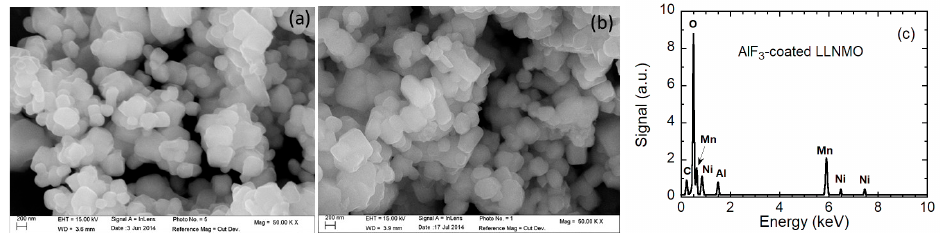
Figure 7. SEM images of ( a ) pristine LLNMO and ( b ) AlF 3 -coated LLNMO. ( c ) EDX spectrum of AlF 3 -coated LLNMO.